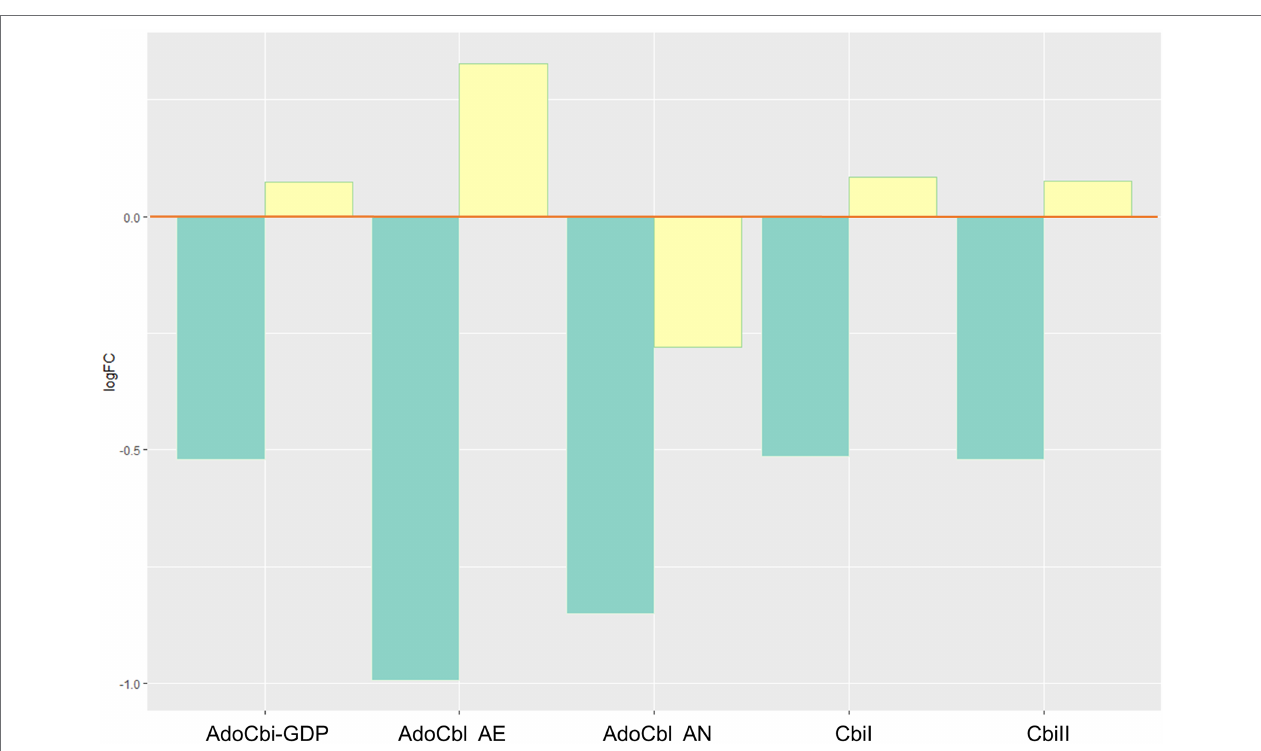
FIGURE 5 | Inferred changes in bacterial vitB 12 metabolism. The bar plots show log2 fold change from paired t tests (means relative to baseline, n = 23): green = after 2 days of heliox saturation; yellow = after decompression. AdoCbi-GDP, adenosylcobalamin biosynthesis from adenosylcobinamide-GDP I ( p = 0.0011); AdoCbl AE, adenosylcobalamin biosynthesis II (aerobic, p = 0.0488); AdoCbl AN, adenosylcobalamin biosynthesis I (anaerobic, p = 0.0338); CbiI, adenosylcobalamin salvage from cobinamide I ( p = 0.0011); and CbiII, adenosylcobalamin salvage from cobinamide II ( p =